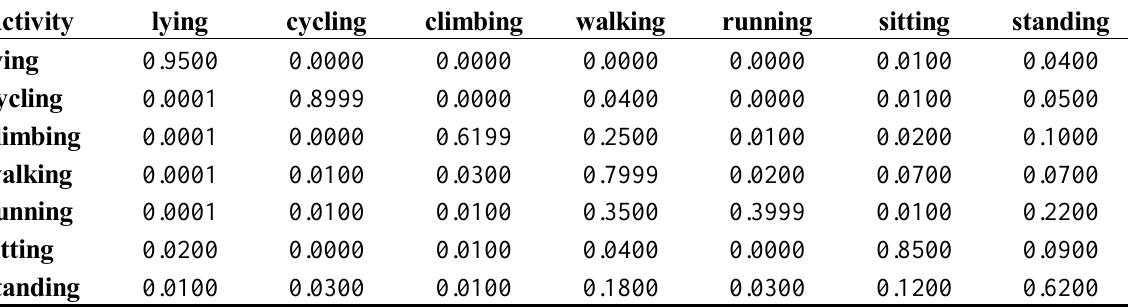
Table 4. Example of